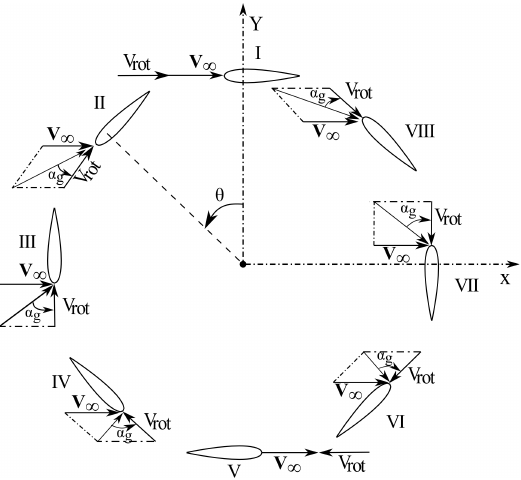
Figure 4. Velocity triangles and blade orientation at eight azimuthal